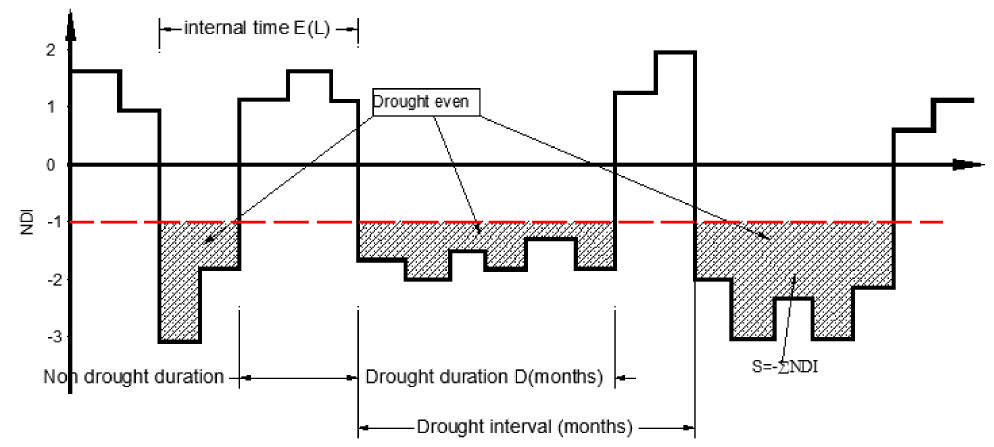
Figure 3. Drought characteristic based on the run